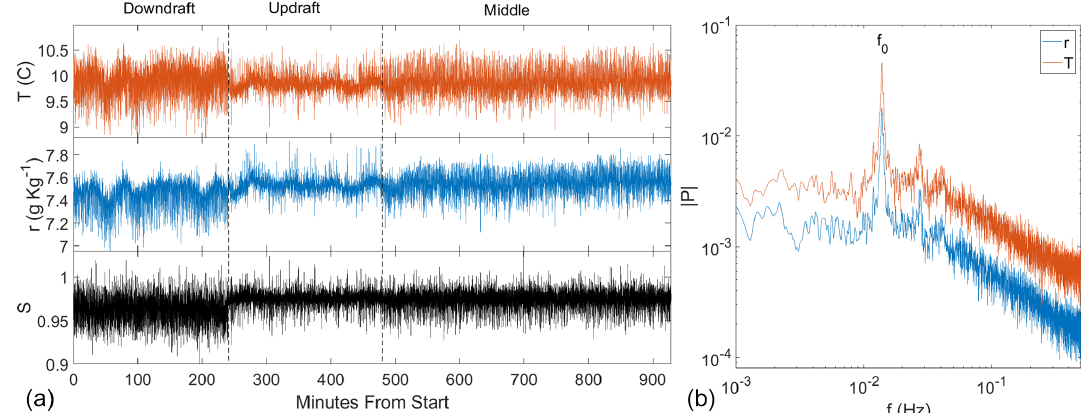
Figure 12. Panel (a) shows the time series of temperature ( T , red), water vapor mixing ratio ( r , blue), and the saturation ratio ( S , black) at different positions in the (cid:53) Chamber. The time series only includes periods in time where the chamber is in steady state conditions. At the beginning of the time series the traverse was near the downdraft side of the chamber. At 240min from the start, the sensors were moved to near the updraft. At 480min they were moved to the center of the chamber and remained there until the end. Panel (b) contains the Fourier spectrum of r and T while the sensors are in the center of the chamber. The oscillation frequency, f 0 , corresponds to a period of ≈ 72s. The spectra are smoothed for